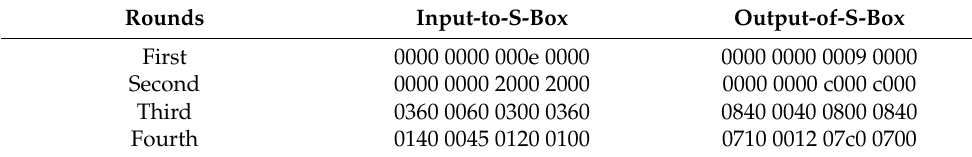
Table 5. Differential Characteristics for the SLA scheme.